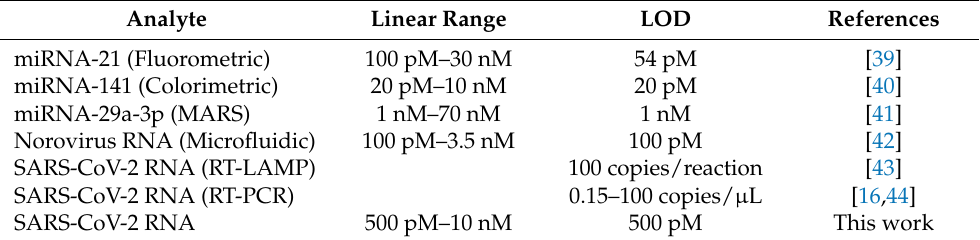
Table 2. Comparison with previously reported RNA detection methods.